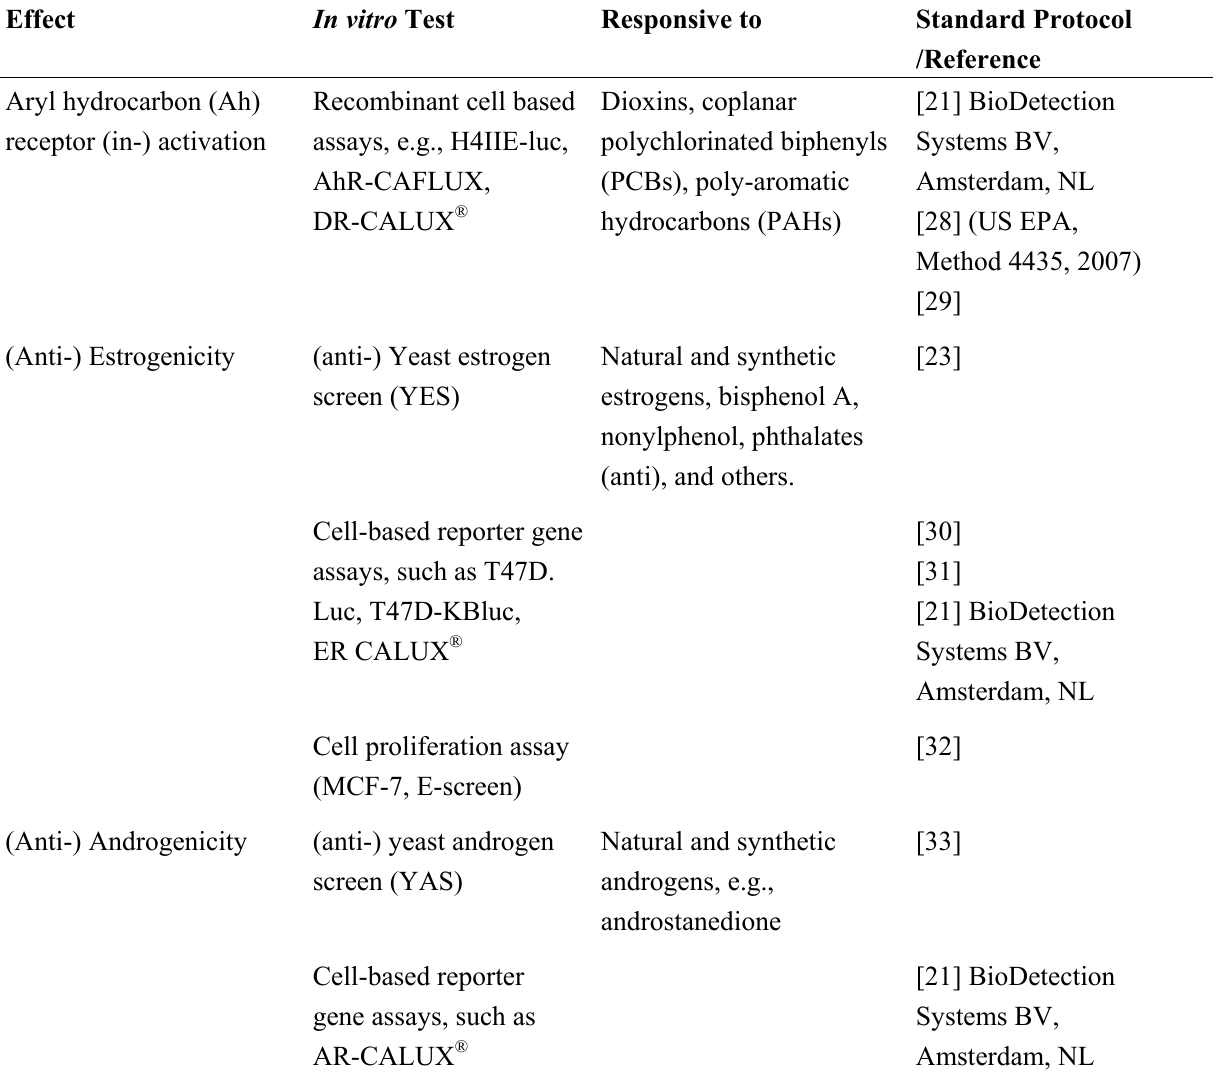
Table 2. Examples of promising effect-based in vitro tests and chemicals they respond to (ISO: International Organization for Standardization; DIN: Deutsches Institut für Normung; German Institute for